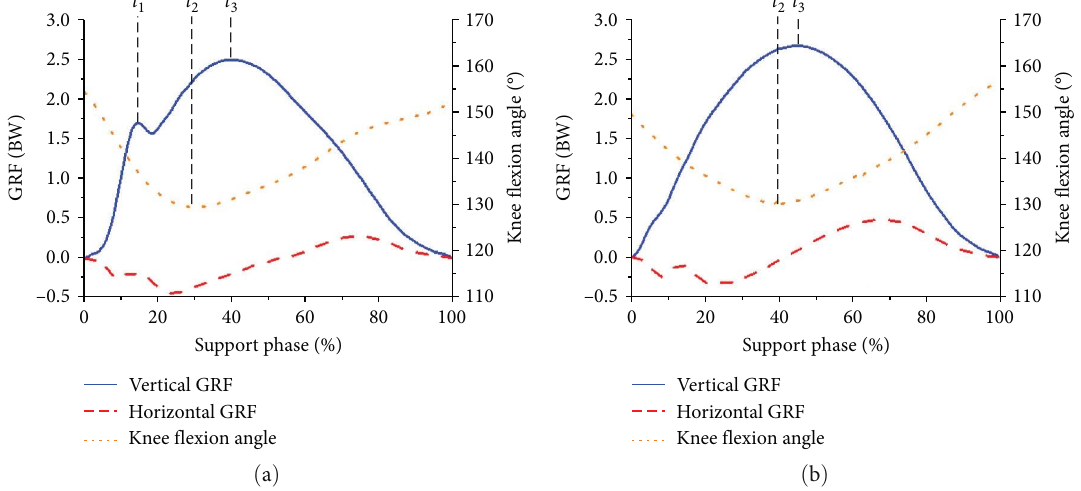
F IGURE 5: GRF and knee fl exion angle (a) in RFS jogging and (b) in FFS